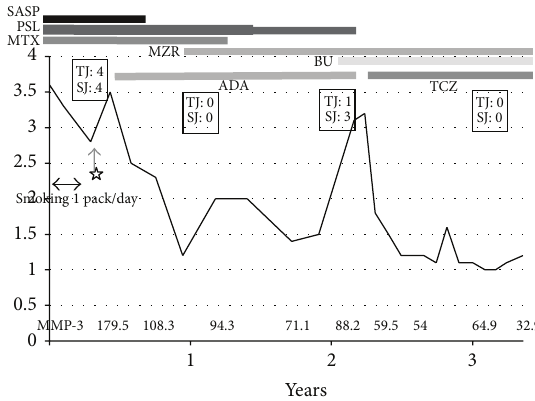
Figure 1: Summary of the clinical course of case 1. DAS28-CRP Dis- ease Activity Score assessing 28 joints with C-reactive protein. SASP: salazosulfapyridine, PSL: prednisolone, ETN: etanercept, TCZ: tocilizumab, and MMP-3: matrix metalloproteinase-3. TJ means tenderjointcountsandSJmeansswollenjointscountsfortheassess- ment of DAS 28-CRP. The asterisk shows the cessation of smoking. Etanercept was initiated 1.5 years after the cessation of smoking.